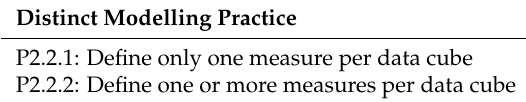
Table 21. Distinct modelling practices of data portals for the number of